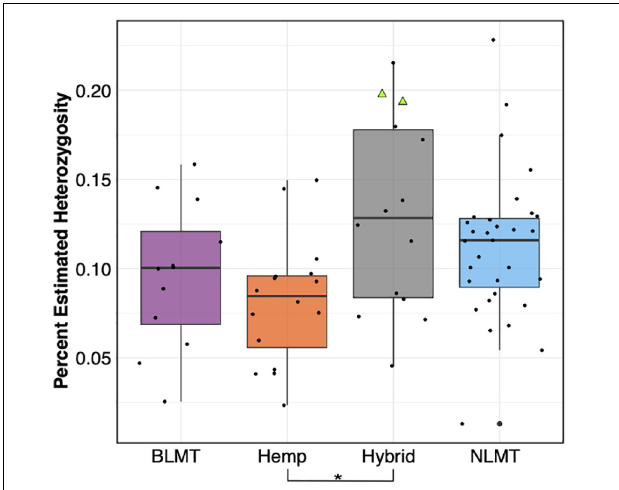
FIGURE 3 | Genome wide heterozygosity. The Hemp lineage differs significantly from the Hybrid grouping with a P < 0.03. The two NIDA samples are presented within the Hybrid grouping by two green triangles.